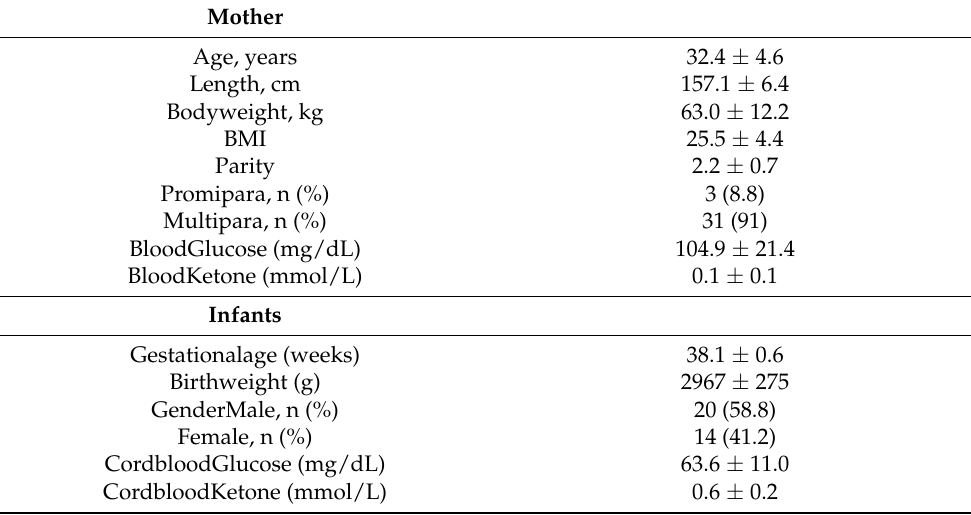
Table 5. Baseline characteristics of mothers and infants (n = 34).